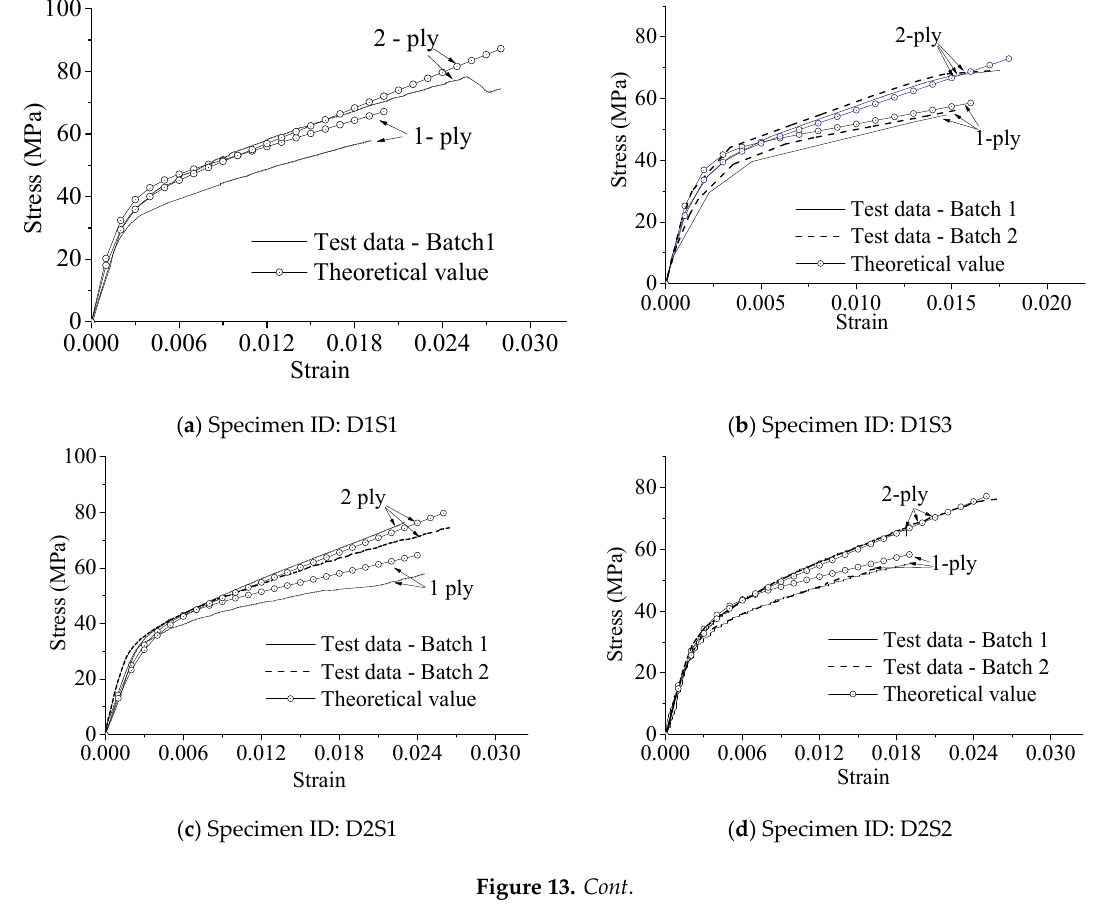
Figure 12. Hardening modulus